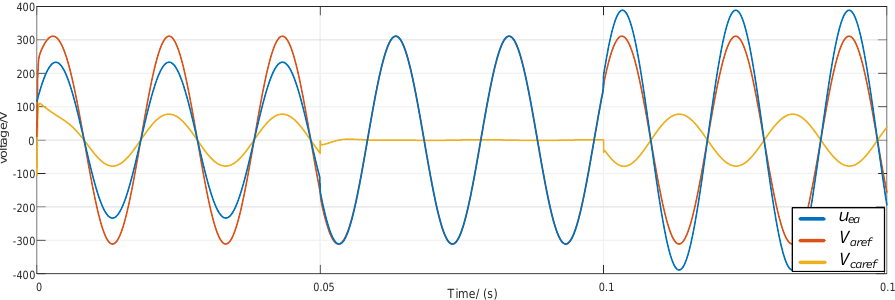
Figure 5. Simulation result of the detection section in the series